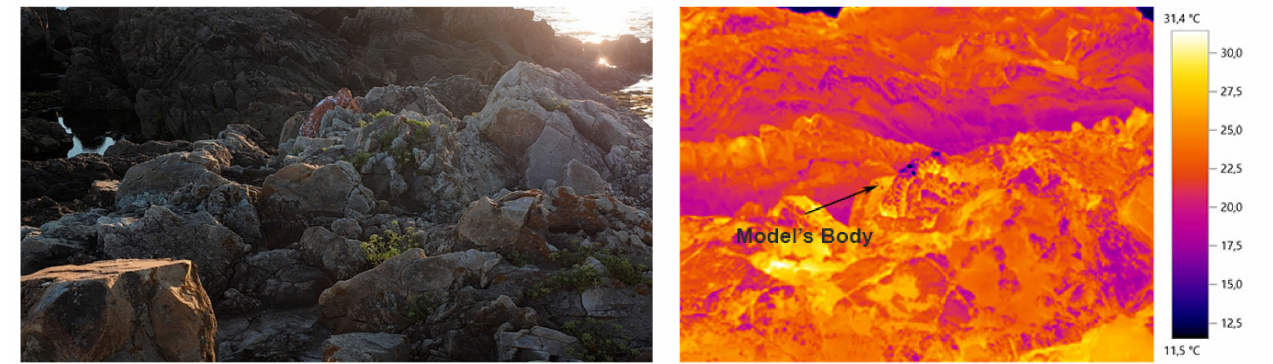
Figure 16. The conceptualized thermal camouflage prototype for the idealized diurnal environment [42].